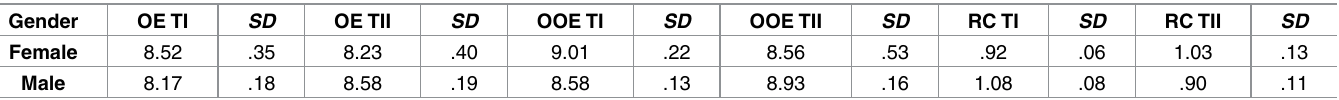
Table 2. Gender differences in other-evaluation index (OE), overall other-evaluation index (OOE) and relative clustering (RC) at Time I (TI) and Time II (TII). Gender OE TI